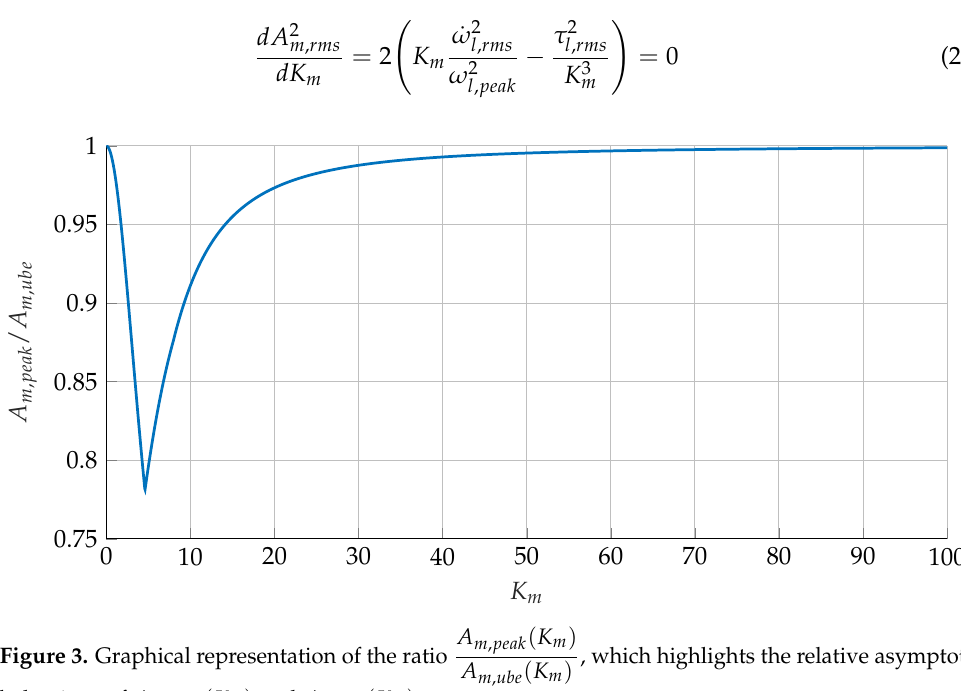
Figure 3. Graphical representation of the ratio behaviour of A m , peak ( K m ) and A m , ube ( K m )